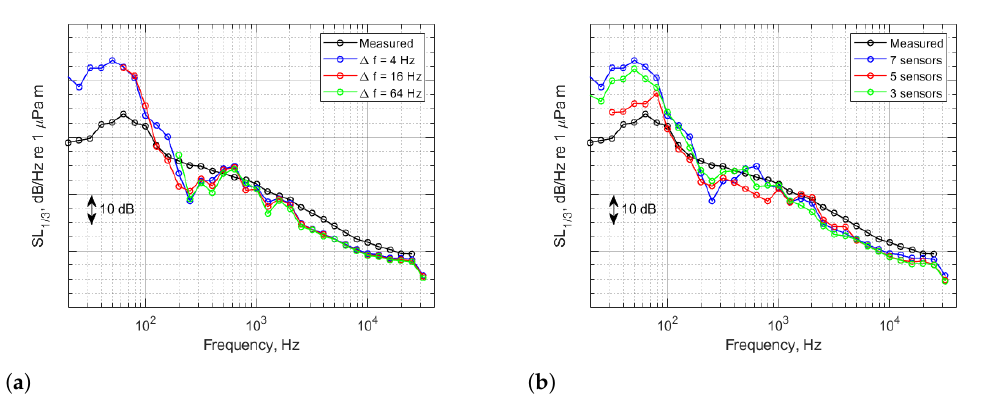
Figure 24. Comparison of source levels estimated for other parameters: ( a ) frequency resolution and ( b ) number of